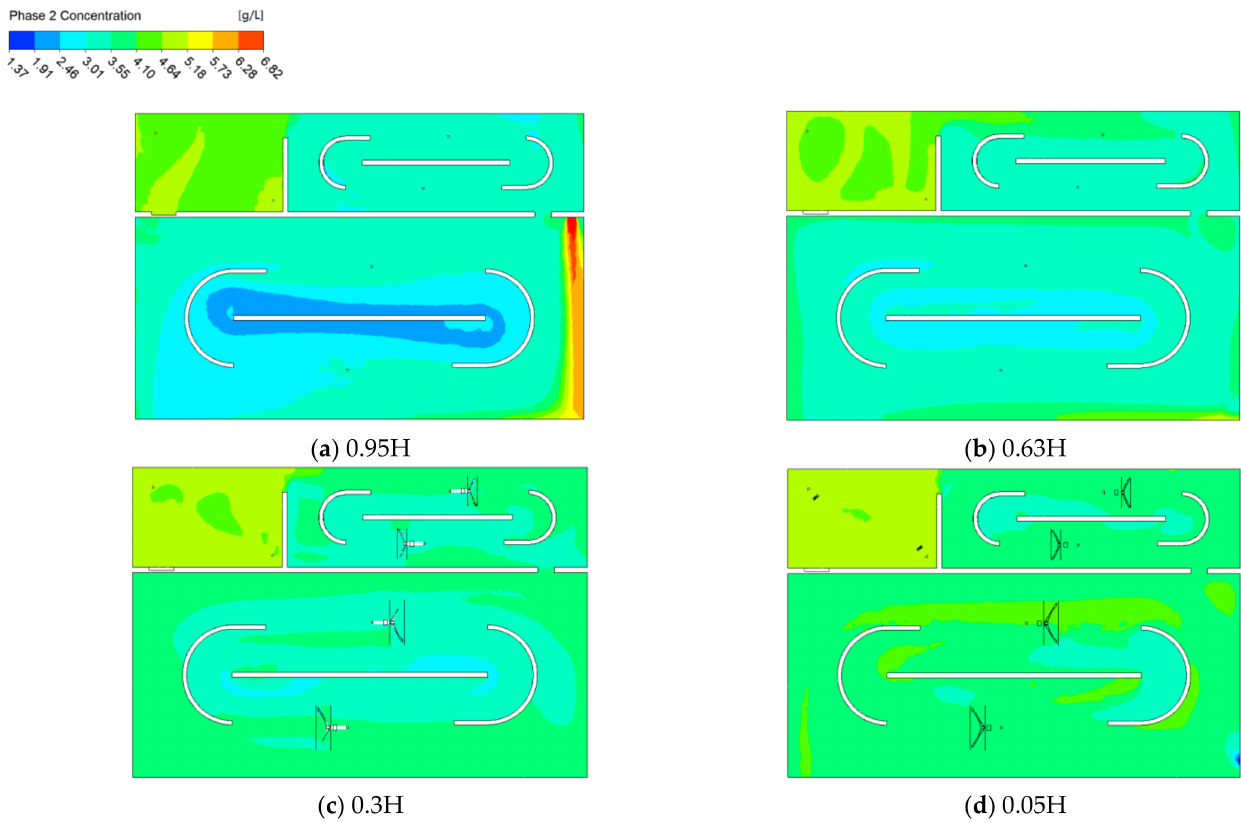
Figure 6. Sludge concentration in the OD at the X-Y cross sections: ( a ) 0.95 H, ( b ) 0.63 H, ( c ) 0.3 H, ( d ) 0.05 H.